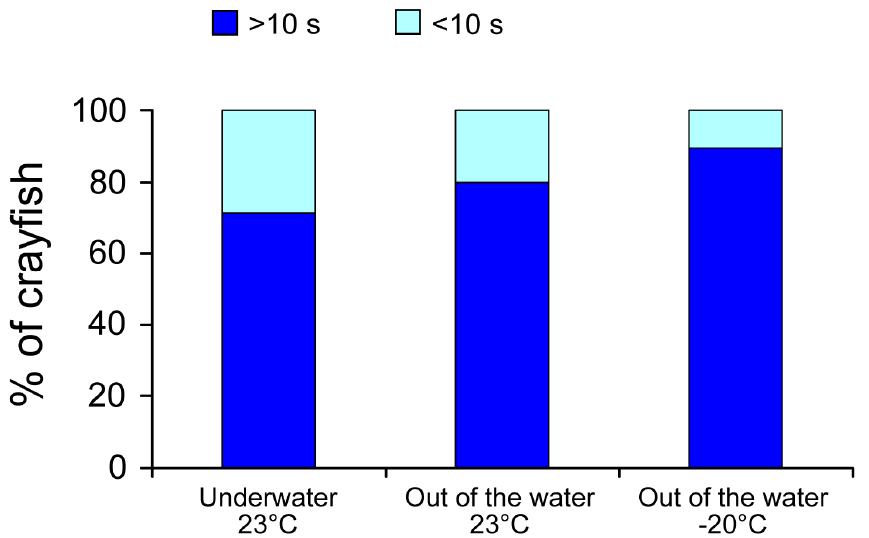
Figure 3. Attractiveness index of the PVC/food dispensers stored underwater at 23 °C and out of the water at 23 °C or − 20 °C, evaluated by considering the time intervals (less or more than 10 s) the crayfish spent on the dispensers after they found them. Data were obtained from 15 (eight females and seven males) crayfish.